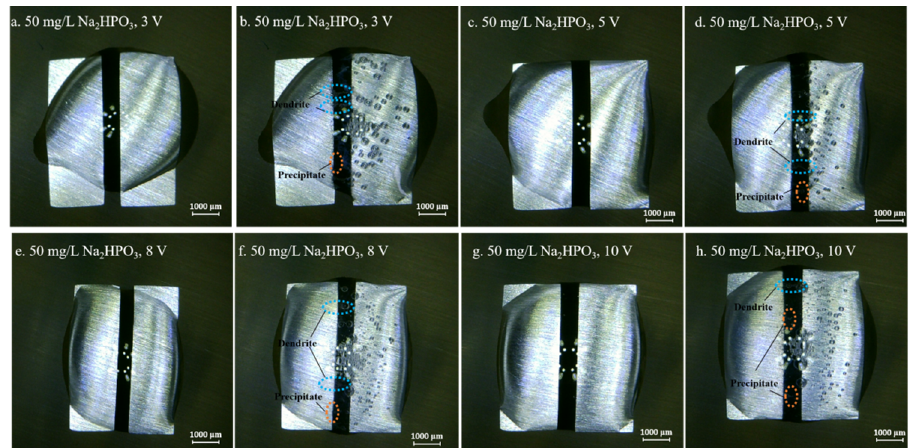
Figure 4. Optic photos for ECM tests of tin under a droplet of 15 μ L containing 0 mg/L Na 2 HPO 4 at various bias voltages (Anode is on the left and cathode is on the right).